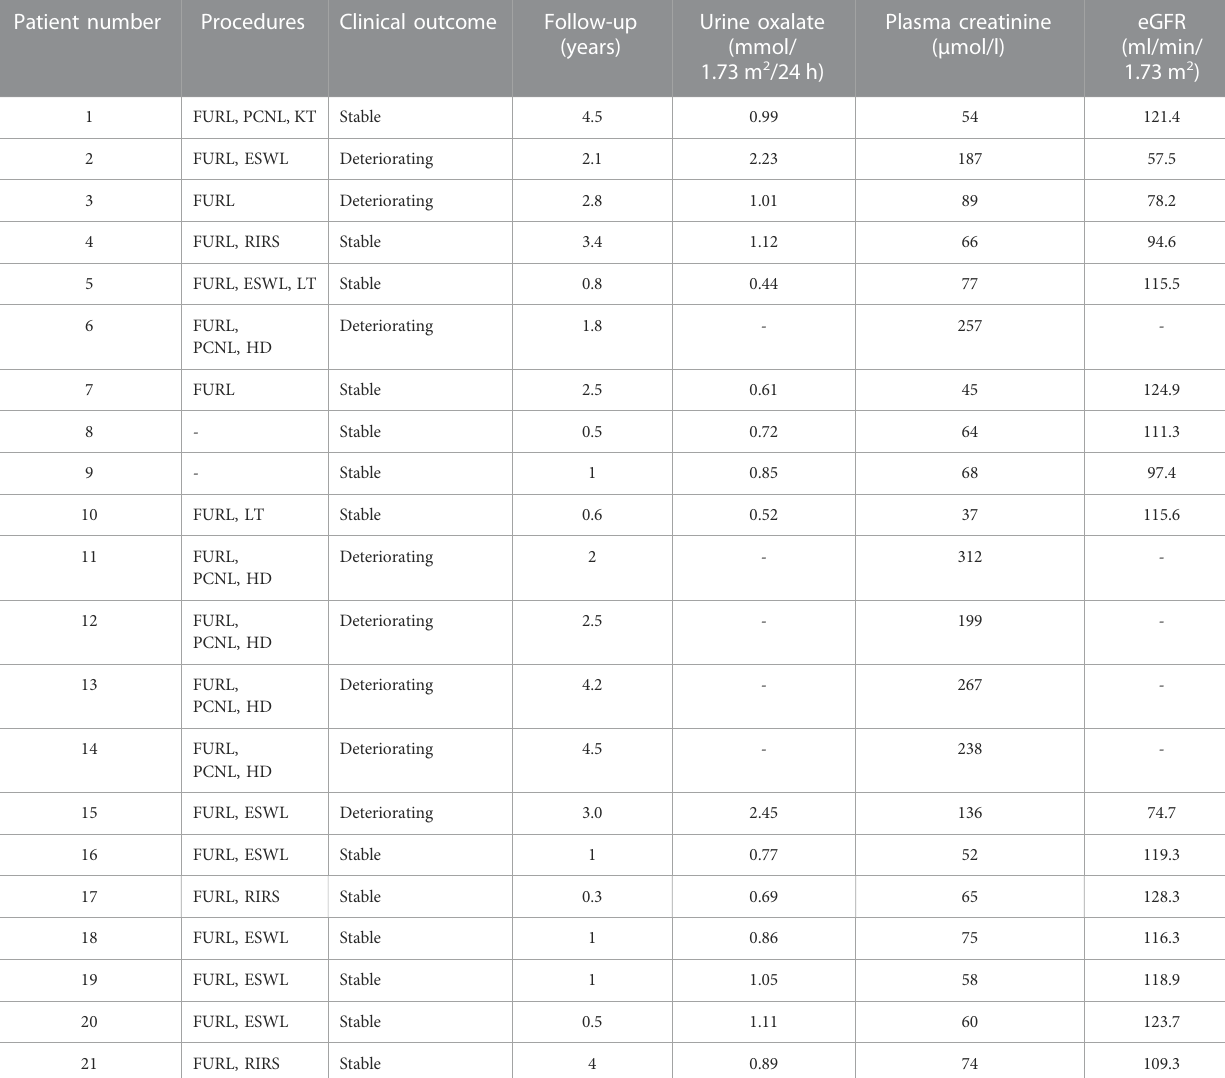
TABLE 5 Management strategies and outcome of 21 patients. Patient